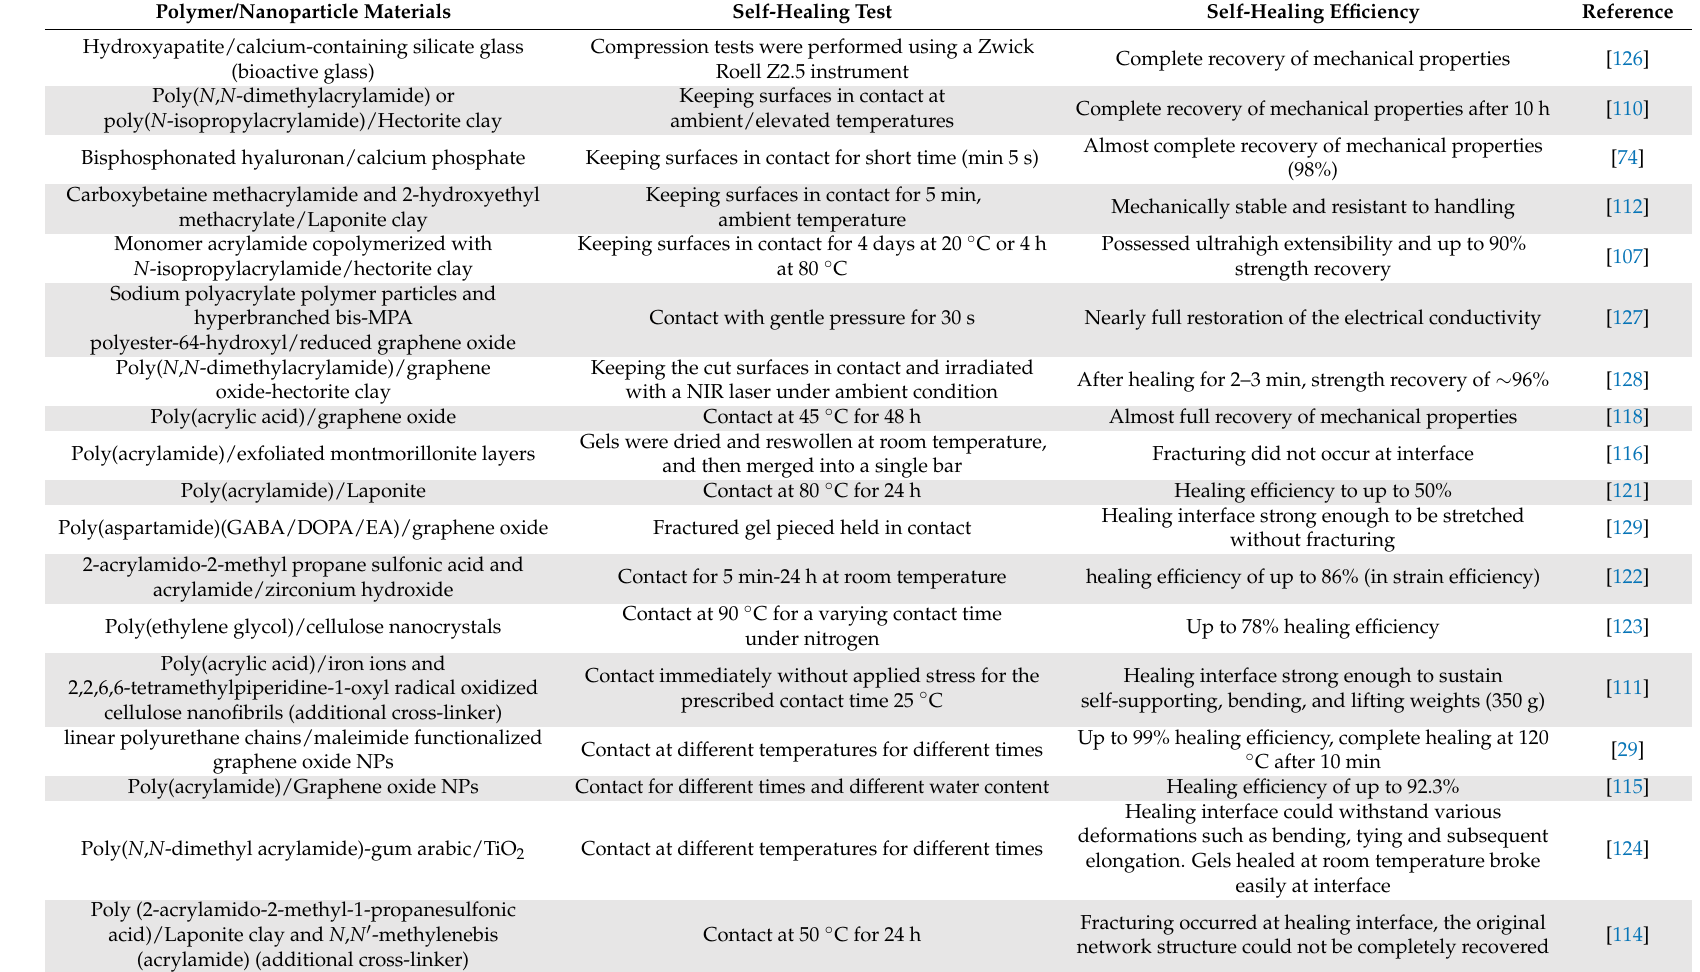
Table 1. Selected recent studies on self-healing nanocomposite hydrogels with different